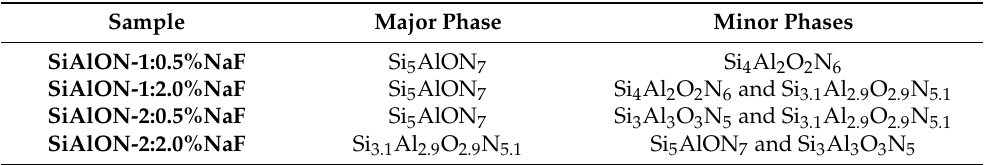
Figure 4. Characteristic parts of XRD patterns of the SiAlON:NaF samples after sintering: ( a ) SiAlON-1:0.5%NaF ; ( b ) SiAlON-1:2.0%NaF ; ( c ) SiAlON-2:0.5%NaF ; ( d ) SiAlON-2:2.0%NaF (the full XRD patterns can be found in the Supplementary Materials). Table 2. Phase composition of the SiAlON:NaF samples after sintering.